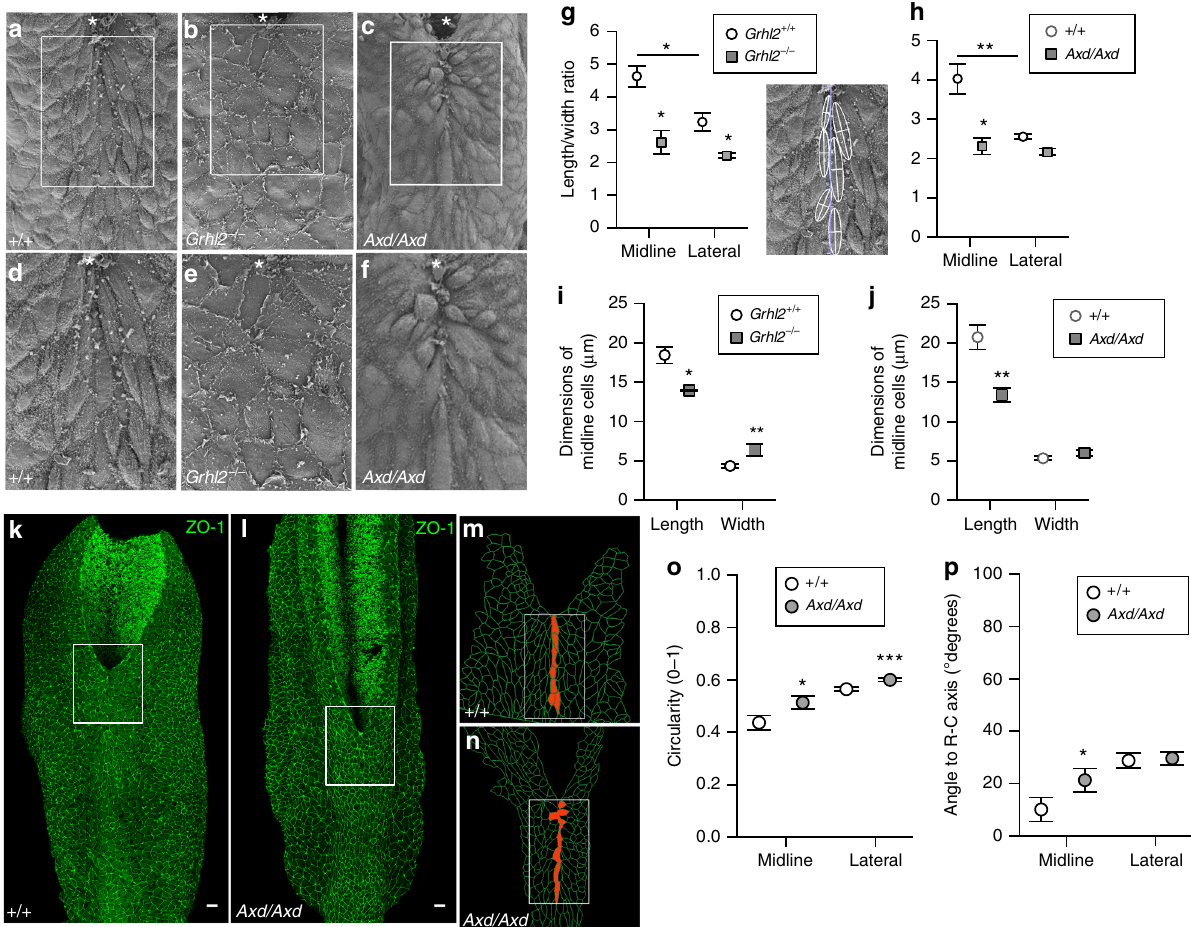
Fig. 6 Grhl2 dysregulation leads to abnormal surface ectoderm cell shape. a – c Dorsal SEM images of the spinal region (oriented with caudal to top) at the PNP closure point (indicated by asterisk) of wild-type, Grhl2 − / − and Axd/Axd embryos at E9.5 (examples have 21 somites). d – f Magni fi ed view of areas boxed in a – c , respectively. g , h Quanti fi cation of the length/width ratio of surface ectoderm cells located in the midline (based on major and minor axes as shown superimposed in inset image) and the lateral cells (remaining cells in the box) in Grhl2 − / − and Axd/Axd mutants and corresponding wild-type controls. Wild-type embryos for both strains show signi fi cant change of length/width ratio between midline and lateral cells (** p < 0.01, * p < 0.05; t -test). Number of cells analysed = 19 – 102 per group; 3 – 5 embryos per genotype (see Supplementary Table 3). i , j Dimensions of cells in the midline. Data represent mean ± SEM (signi fi cant difference from wild type in equivalent region, ** p < 0.01, * p < 0.05; t -test). k , l Cell outlines were segmented (using tissue analyser) from dorsal images of whole-mount ZO-1 immunostaining of the PNP region of Axd/Axd and + / + embryos at E9.5. Scale bars: 50 μ m. m , n Magni fi ed view of boxed areas in k and l . o , p Circularity and angle from the rostro-caudal axis were determined for midline cells (orange in m , n ) and lateral cells (remaining cells in box in m , n ) for Axd/Axd and + / + embryos ( n = 3 per genotype; 22 – 27 midline cells and 260 – 332 lateral cells per genotype; signi fi cant difference from wild type, *** p < 0.001, * p < 0.05; t -test). Source data are provided as a Source Data fi